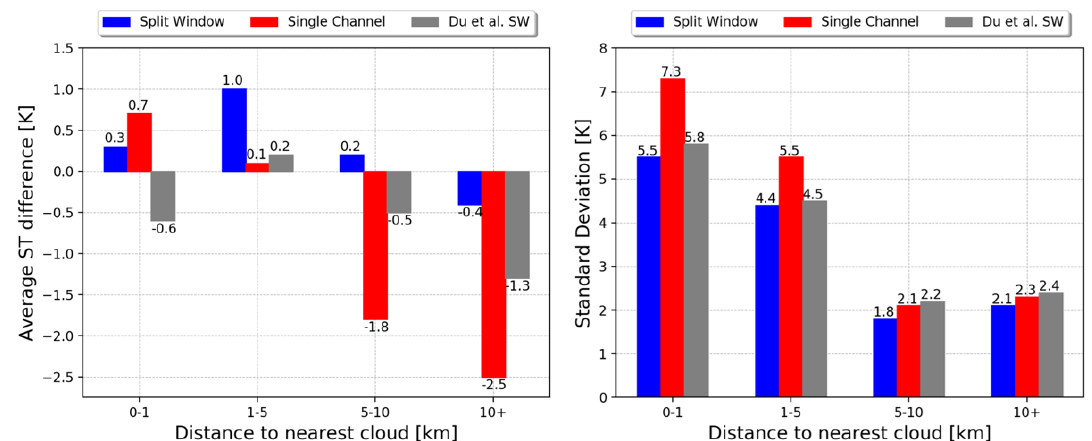
Figure 9. Results over land sites: the average differences between the reference temperature measurements and the Landsat-derived surface temperatures for the three retrieval methodologies ( left ), and the corresponding standard deviations of the residuals ( right ).